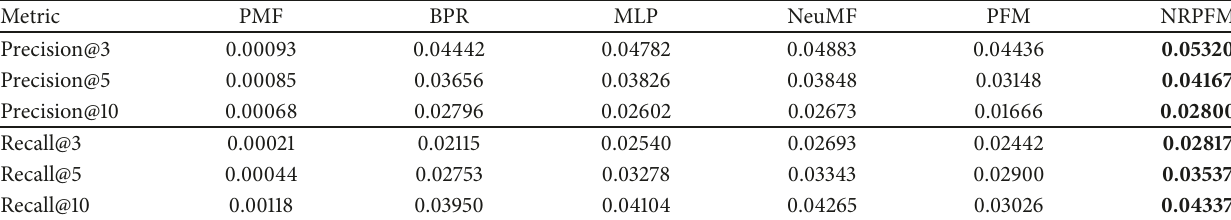
Table 3: Performance comparison on Gowalla.